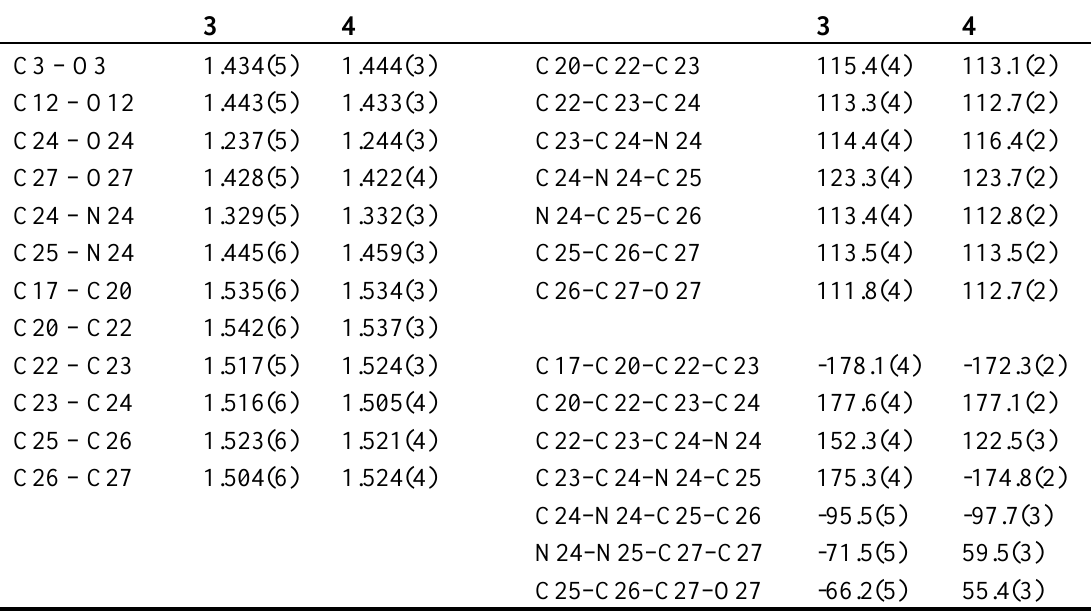
Table 3. Selected geometric parameters (Å, °) of 3 and 4